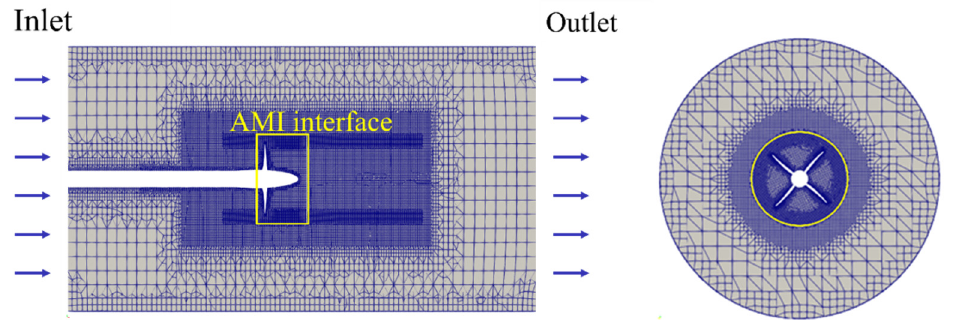
Figure 2. Typical mesh